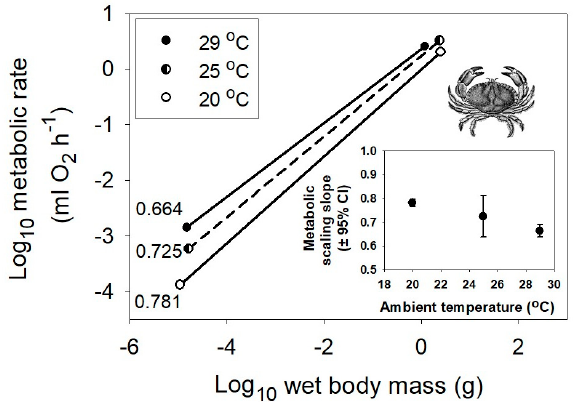
Figure 1. Interspecific scaling of metabolic rate in relation to body mass of marine crustaceans at three different habitat temperatures, 29, 25 and 20 °C (data from [53]). The correlation coefficients ( r ) and sample sizes ( n ) are 0.963 and 212, 0.727 and 249, and 0.977 and 247, respectively. All probability values are <0.001. The inset graph shows the negative relationship between the metabolic scaling slope (±95% confidence intervals) and habitat temperature. The crab picture is from [54]. Challenges 2018 , 9 , x